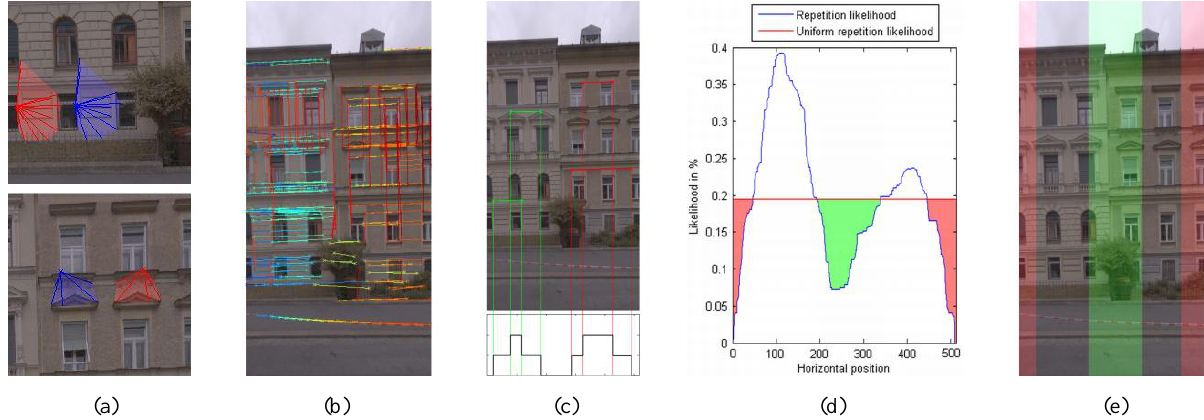
Figure 8: From street side data to separation . (a) Matching of arbitrary areas (b) Detected repetitive patterns (color-coded lines) (c) Projection results in a match count along the horizontal axis (d) Thresholding the repetition likelihood with the uniform repetition likelihood (e) Resulting repetitive areas and separation areas (green) (taken from Wendel et al.